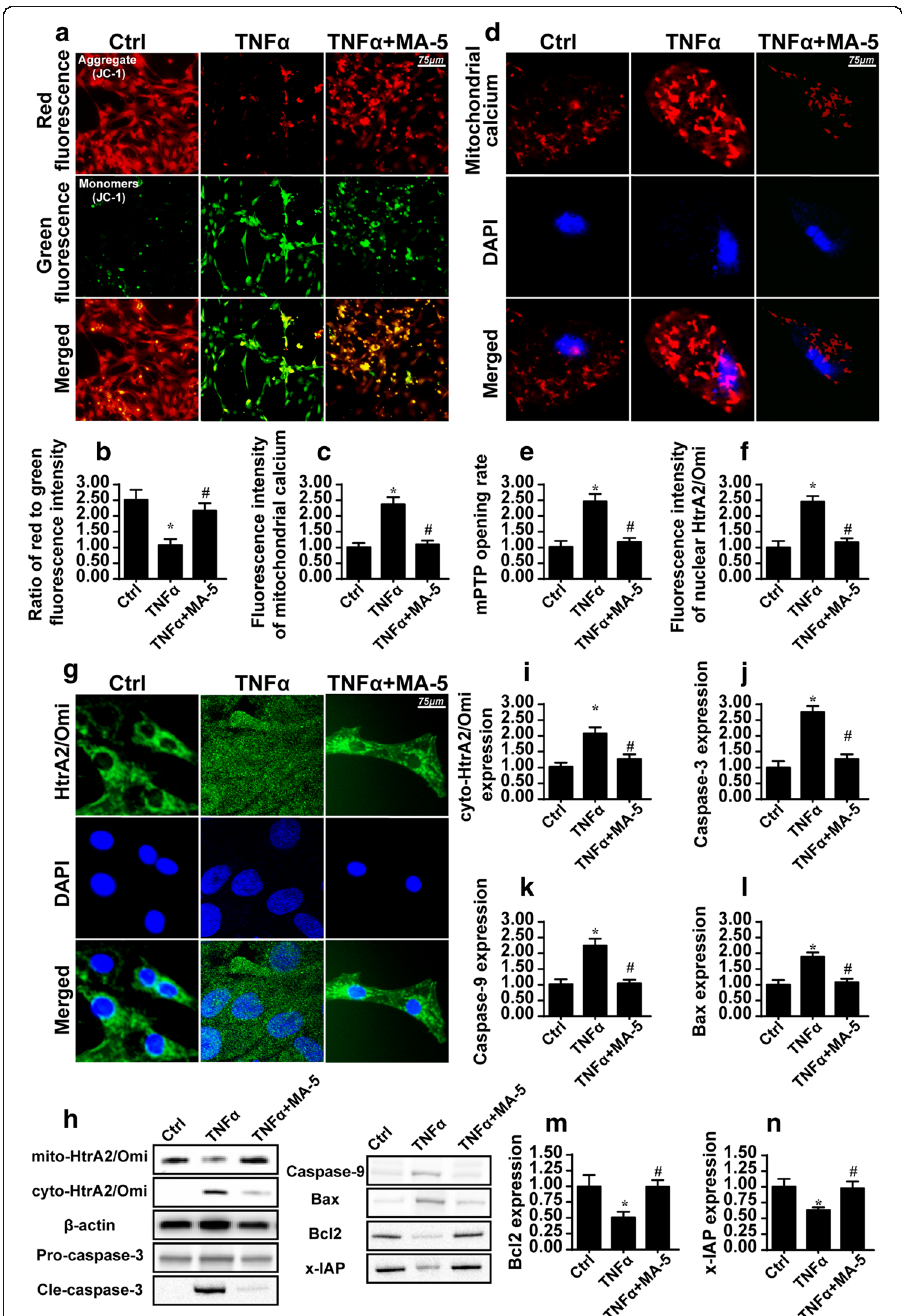
Fig. 2 MA-5 preserved the mitochondrial function. a and b The mitochondrial potential was measured via JC1 staining in control cells (Ctrl), and in cells treated with 10 ng/ml TNF α (TNF α ), or 10 ng/ml TNF α and 5 μ M MA-5 (TNF α +MA-5). c and d The mitochondrial calcium level was assessed as fluorescence intensity in control cells (Ctrl), and in cells treated with 10 ng/ml TNF α (TNF α ), or 10 ng/ml TNF α and 5 μ M MA-5 (TNF α +MA-5). e The rate of mPTP opening was determined in control cells (Ctrl), and in cells treated with 10 ng/ml TNF α (TNF α ), or 10 ng/ml TNF α and 5 μ M MA-5 (TNF α +MA-5). f and g The immunofluorescence assay for HtrA2/Omi in cells treated with 10 ng/ml TNF α (TNF α ), or 10 ng/ml TNF α and 5 μ M MA-5 (TNF α +MA-5). h through n Western blots were used to analyze the impact of MA-5 and TNF α treatment on apoptotic proteins in cells treated with 10 ng/ ml TNF α (TNF α ), or 10 ng/ml TNF α and 5 μ M MA-5 (TNF α +MA-5). * p <0.05 vs. control (Ctrl) group; # p <0.05 vs. TNF α